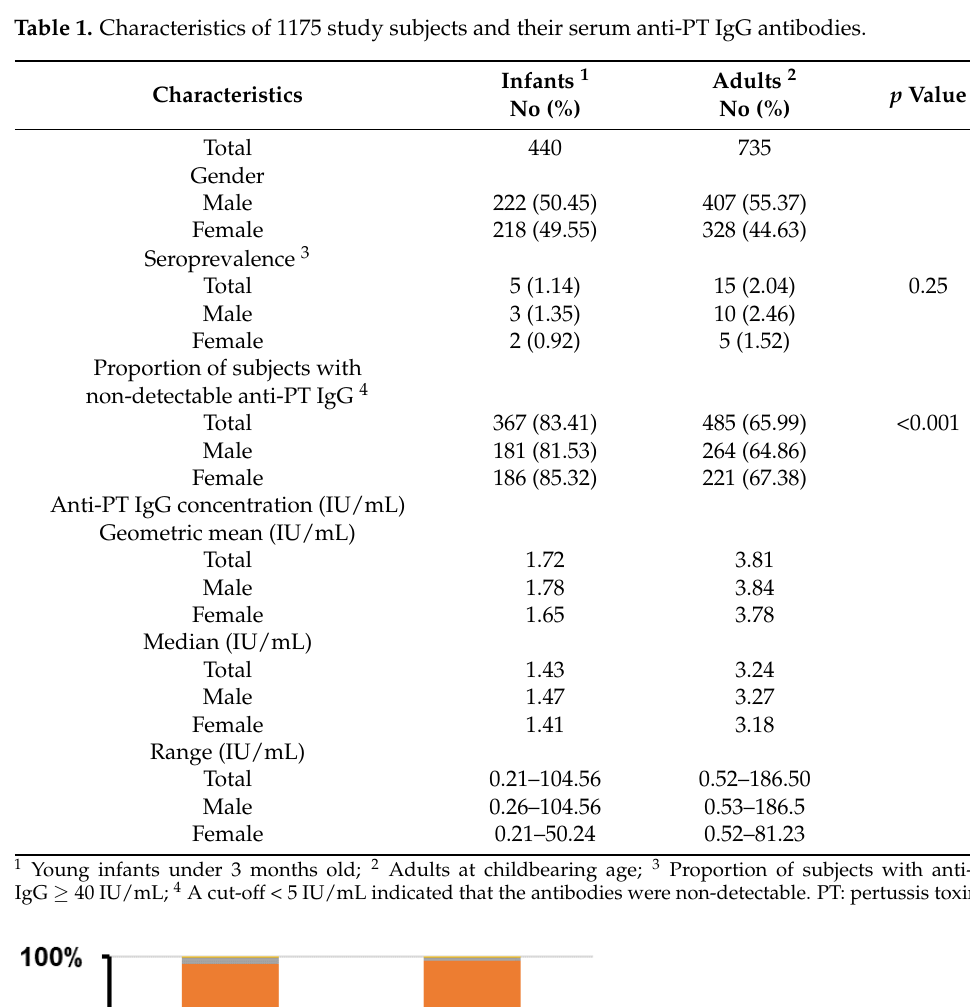
Table 1. Characteristics of 1175 study subjects and their serum anti-PT IgG antibodies.